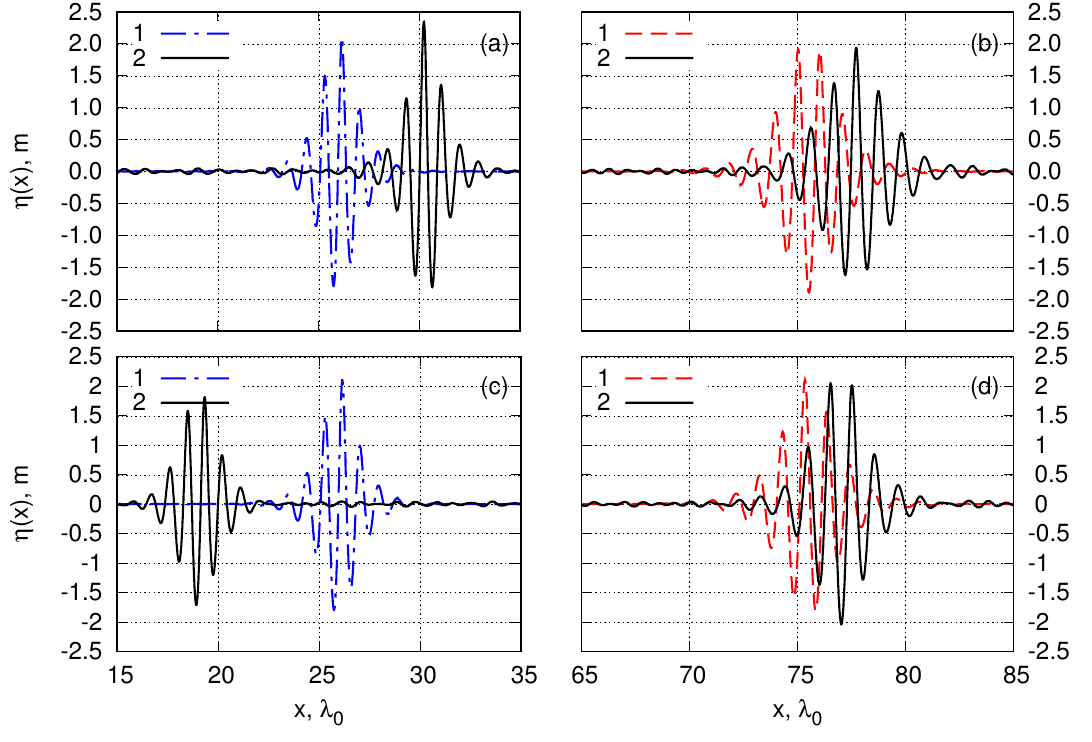
Figure 11. Comparison of the breathers after mutual collision and the same breathers propagated without interaction in experiment 3 with relative velocity ∆ V = 8%. The considered moment of time is t = 50 λ 0 / U 0 . The pictures ( a , b ) correspond to the relative phase ∆ φ ≈ 0 and the pictures ( c , d ) to the relative phase ∆ φ ≈ 1.5 of the colliding breathers. The black solid curves 2 show surface elevation η ( x ) after collision of breathers. The red dashed curves 1 show the left breather propagated in the absence of right breather. The blue dash-dotted curves 1 show the right breather propagated in the absence of the left